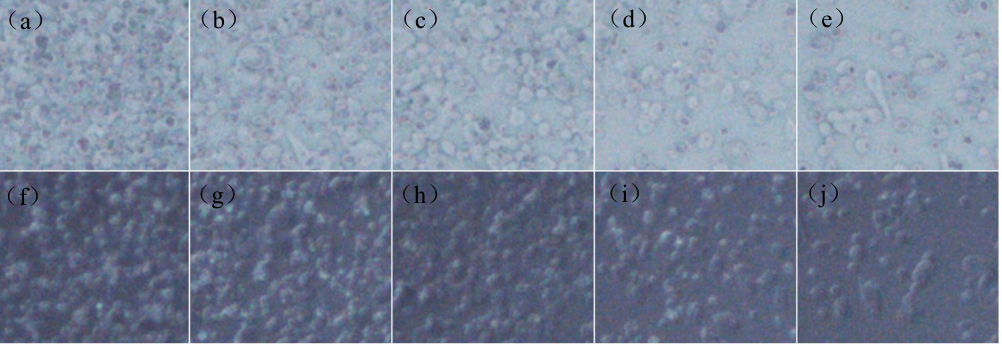
Figure 8. The digital microscope pictures of microstructure morphology of anti-glare sample by different the spray gun displacement speed ( a ) 170 mm/s (90°); ( b ) 235 mm/s (90°); ( c ) 300 mm/s (90°); ( d ) 400 mm/s (90°); ( e ) 500 mm/s (90°); ( f ) 170 mm/s (25°); ( g ) 235 mm/s (25°); ( h ) 300 mm/s (25°); ( i ) 400 mm/s (25°); and ( j ) 500 mm/s (25°) with the sol-gel deliver and air transport pressures of 120 kPa and 300 kPa, respectively.